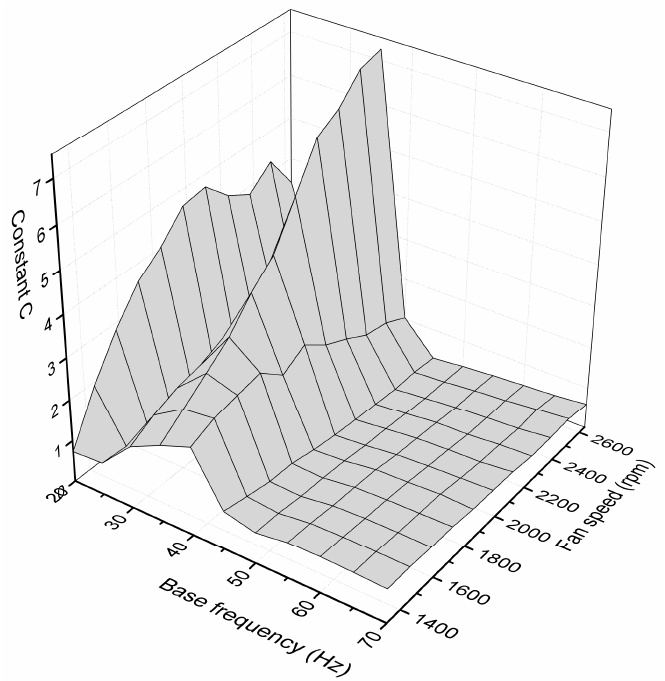
Figure 11. Surface map of constant c.